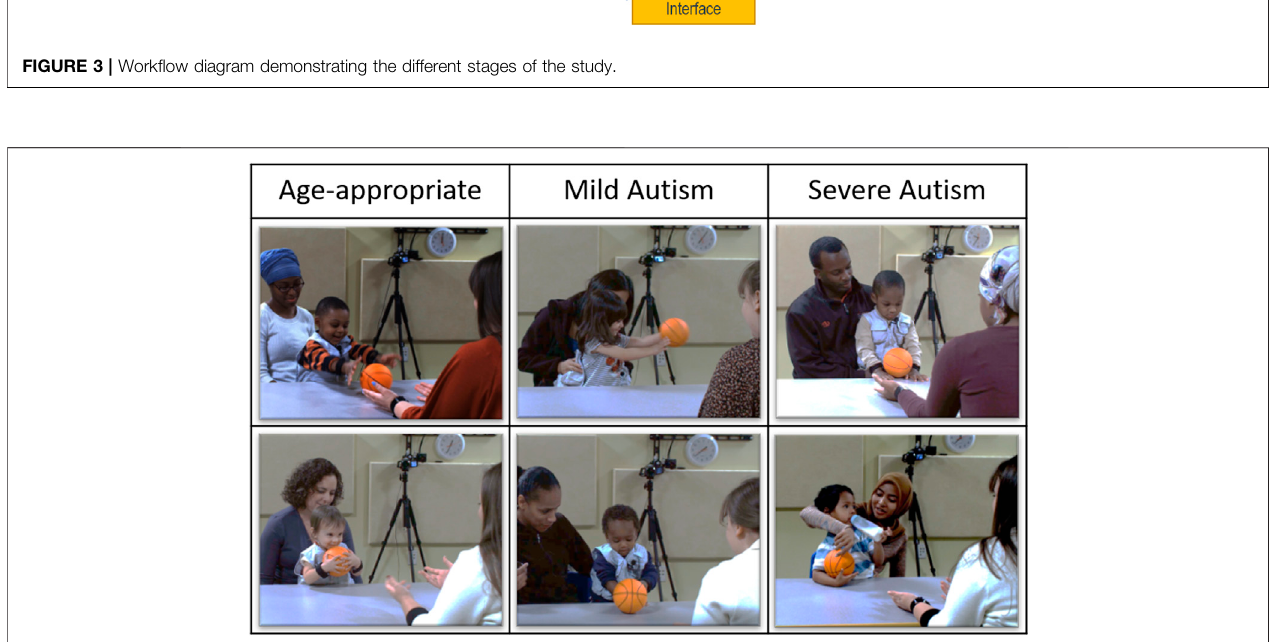
FIGURE 4 | Video vignettes of real children (MMDB